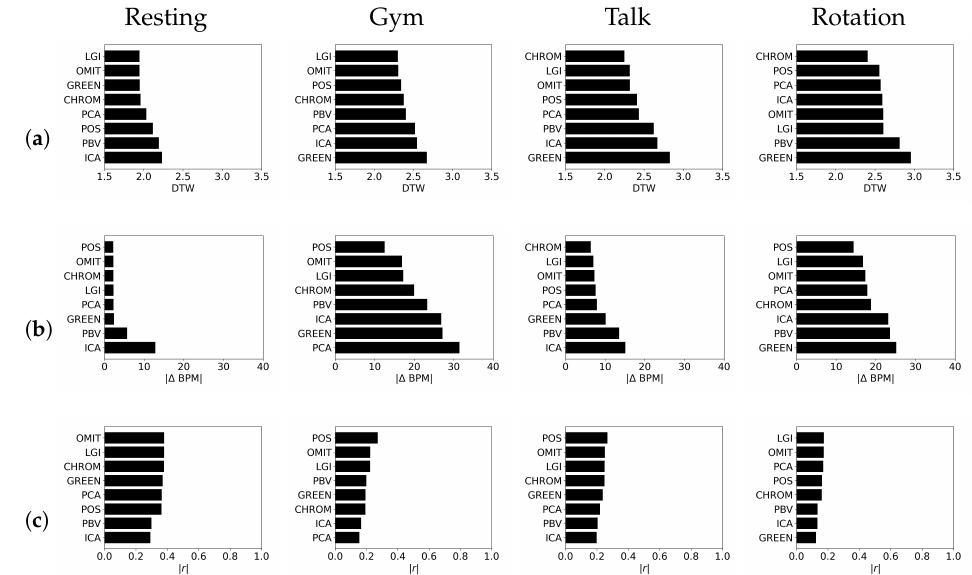
Figure 5. Average DTW ( a ), | ∆ BPM | ( b ), | r | ( c ) over all participants, windows, and ROIs for every rPPG method. Note that BPM = beats per minutes, DTW = dynamic time warping, PPG = photoplethys- mography, rPPG = remote photoplethysmography, | r | =